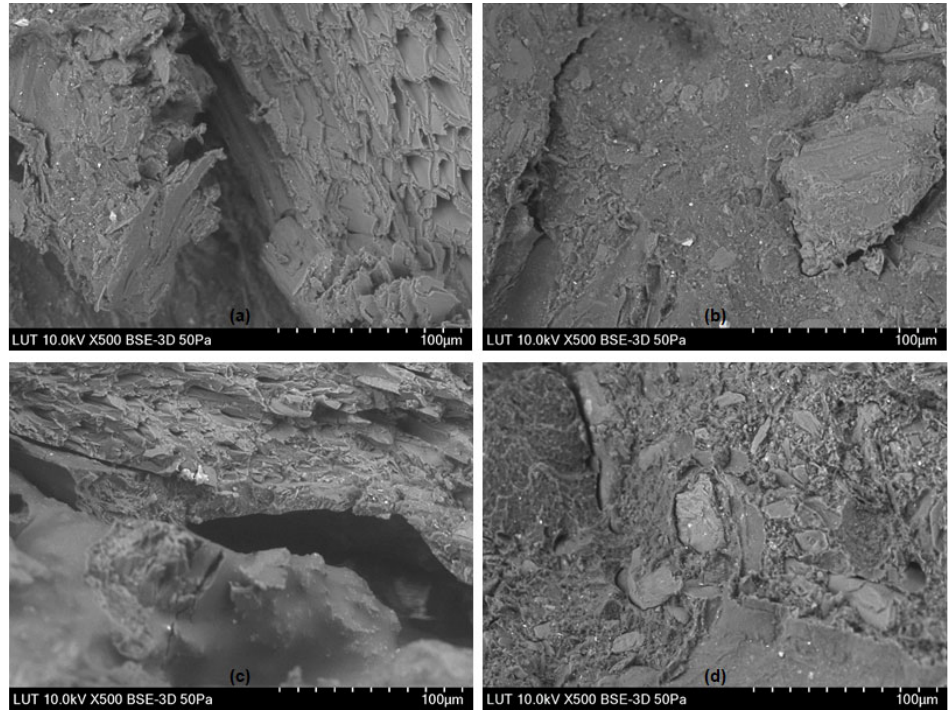
Figure 6. SEM images of palmyra ‐ fiber ‐ reinforced composites ( a ) R ‐ ABS/10PF; ( b ) R ‐ ABS/10PF ‐ S; ( c ) R ‐ ABS/20PF; and ( d ) R ‐ ABS/20PF ‐ S. ( c ) R-ABS/20PF; and ( d )